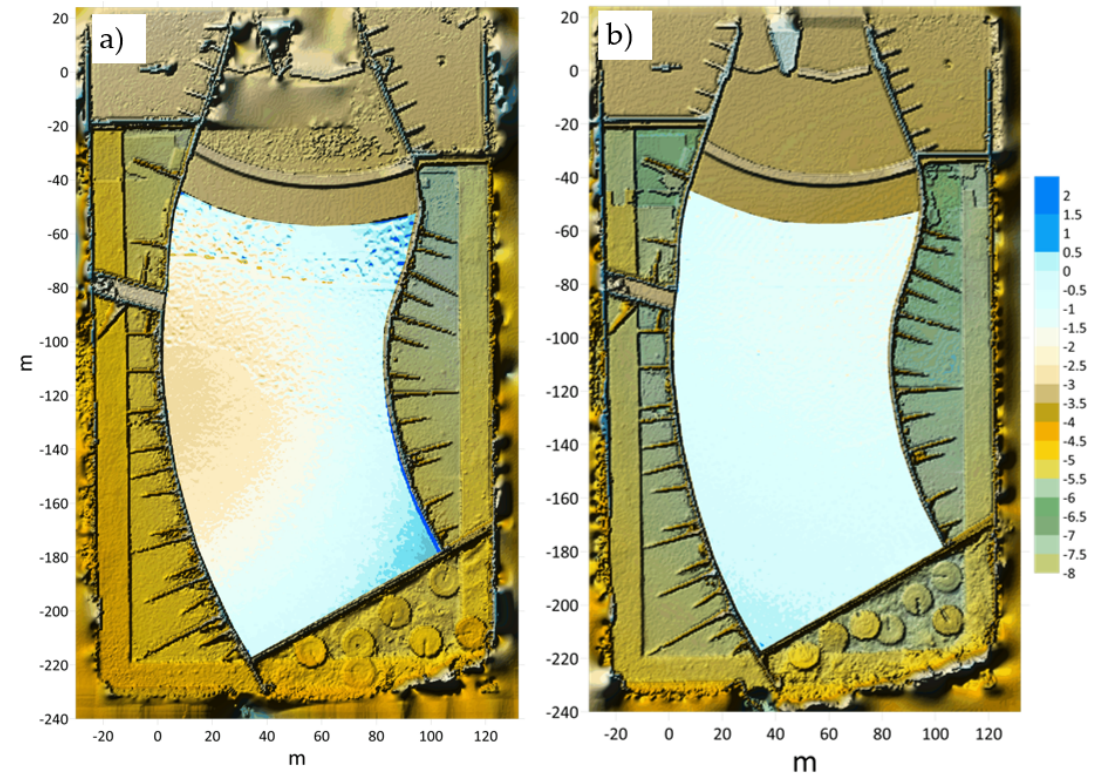
Figure 14. Comparison between the erosion/deposition maps (dimensions in meters) reconstructed processing images of ( a ) Test #2a (left) and ( b )Test #2b (right); for both tests, the discharge was set to 830 m 3 /s. The protection area has been realized employing Antifer blocks arranged with random (left-hand side panel) and closed pyramid (right-hand side panel) configurations.